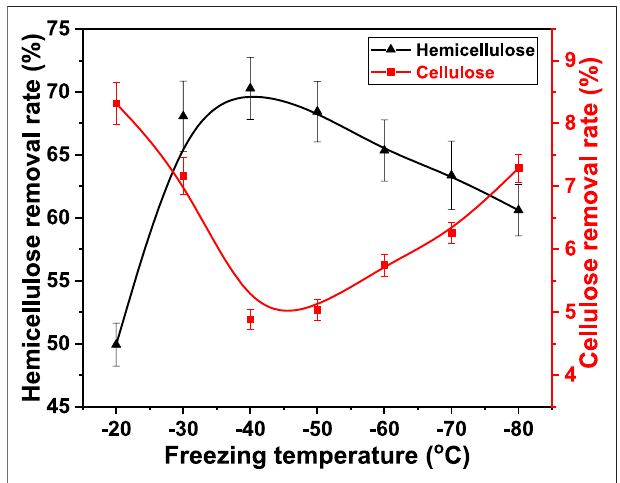
FIGURE 1 | Effect of freezing temperature on the removal rate of cellulose and hemicellulose from bagasse fi ber in FT/AT.